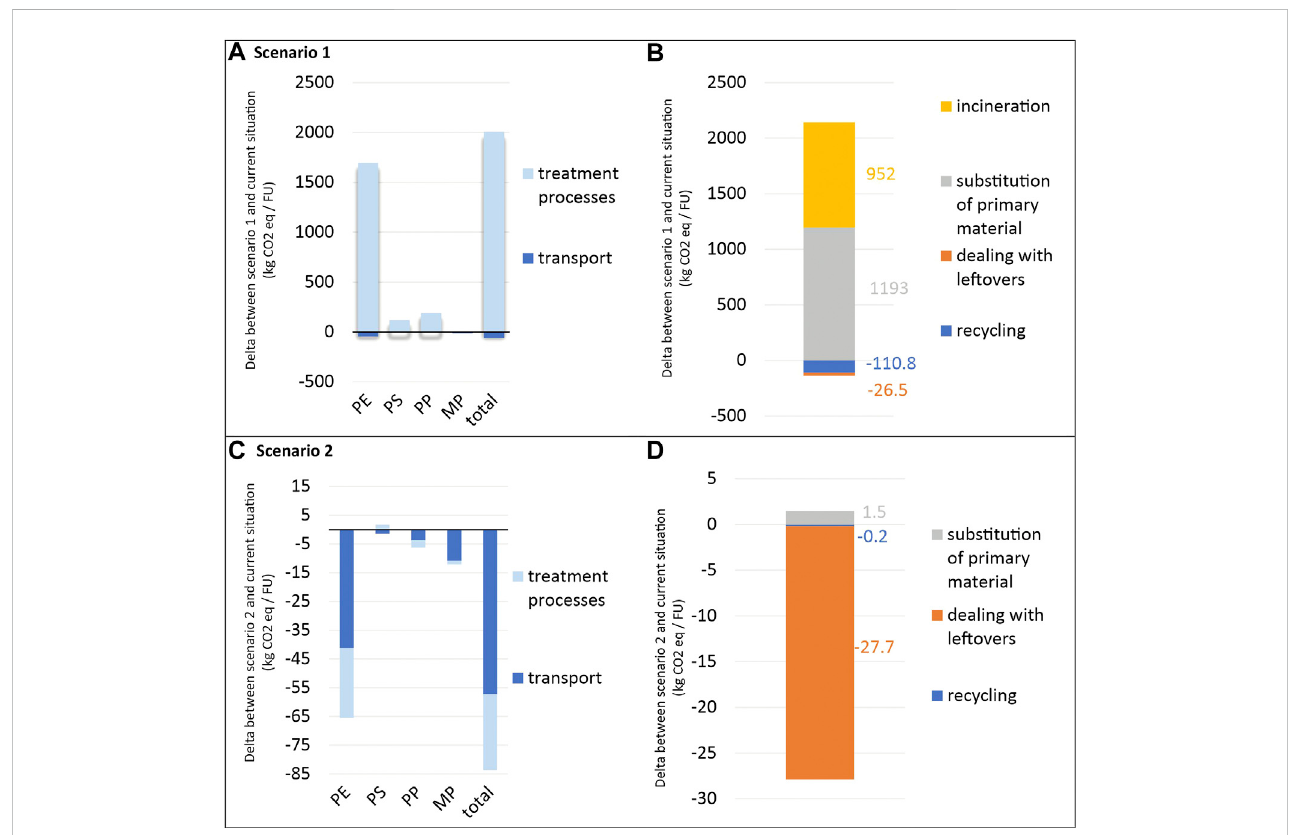
FIGURE 2 ResultsoftheimpactassessmentforGWPforbothscenarios.Breakdownofresultsintotreatmentandtransportprocessesforscenario1 (A) andscenario 2 (C) and more detailed breakdown of individual treatment processes for scenario 1 (B) and scenario 2 (D) . The results are presented as a delta between the scenario and the current